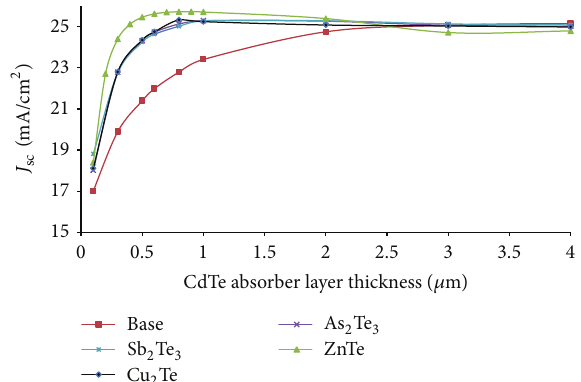
Figure 3: Effect of different BSF on cell short circuit current density on proposed cell with variable absorber thickness.